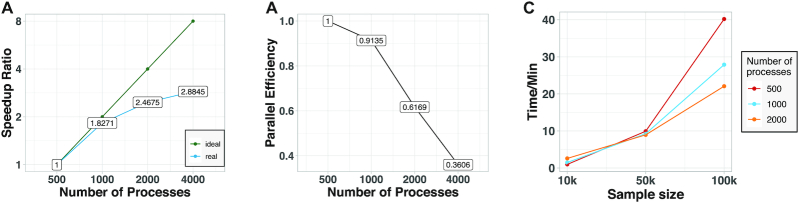
Strong scaling results and parallel efficiency of the D-EE algorithm on an LSSC-IV supercomputer. We apply D-EE on the iPSC dataset by using 500, 1,000, 2,000, and 4,000 processes, respectively. A: The strong speedup ratio increases with increase in the number of processes.The green line represents the ideal speedup ratio and the blue line represents the speedup ratio obtained by D-EE. B: The parallel efficiency decreases at an acceptable rate with the increase in number of processes. C: Computational times consumed for 10,000, 50,000, 100,000 samples under 500, 1,000 and 2,000 processes, respectively.